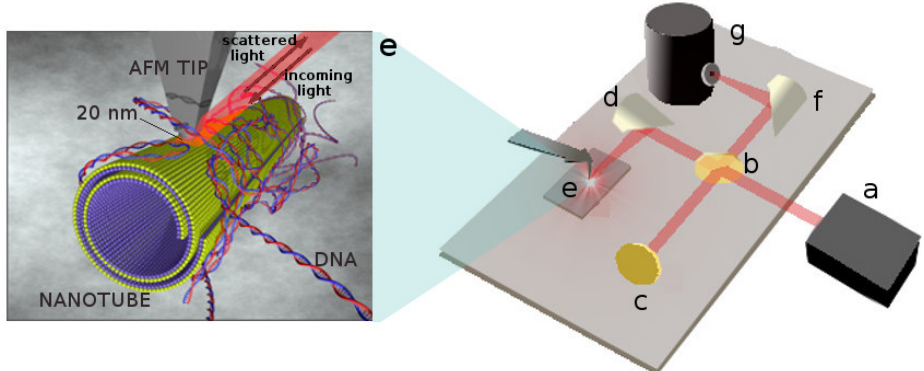
Figure 1. Schematic representation of the nano-FTIR apparatus: ( a ) DFG (Difference Frequency Generation) broadband laser source working in the mid-infrared range; ( b ) KBr beam splitter; ( c ) Moving mirror for Fourier transfom; ( d ) Focusing parabolic mirror aimed at focusing the incoming beam to the tip apex; ( e ) Nanoscopic conductive tip (PtIr) and DNA–HNs sample; ( f ) Parabolic mirror focusing light to the detector; ( g ) MCT (Mercury Cadium Tellurium) liquid nitrogen cooled detector for